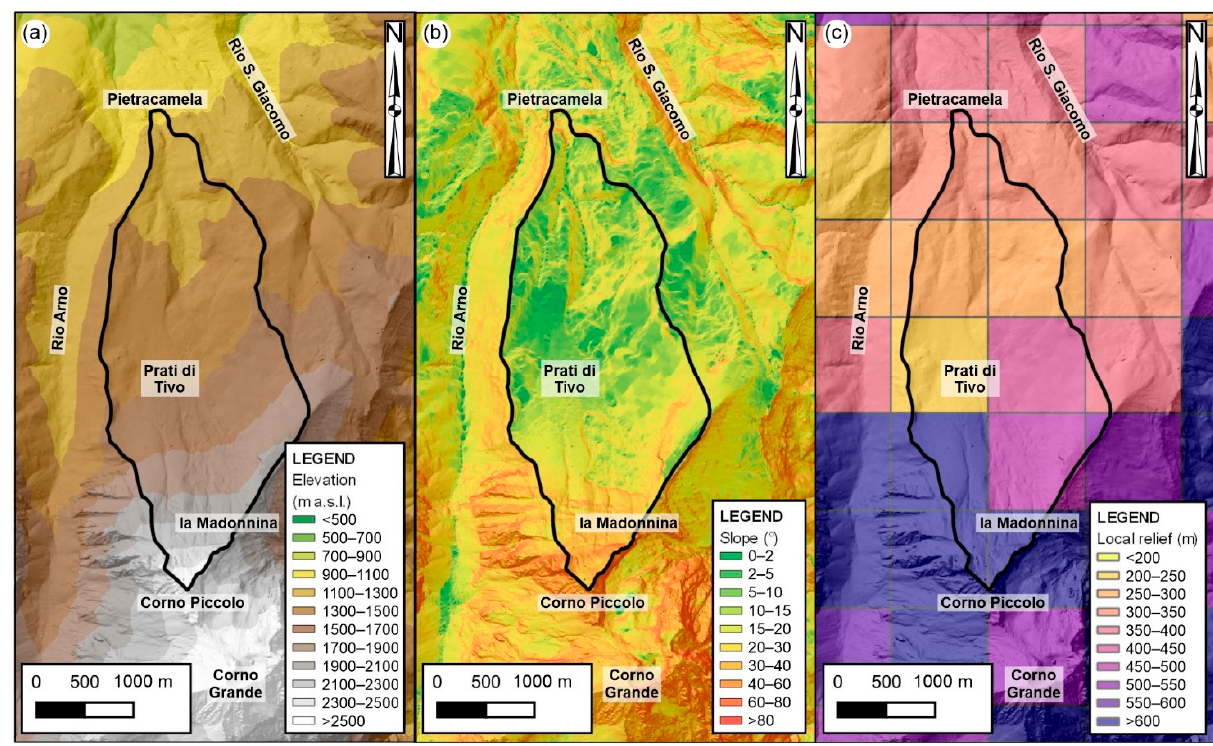
Figure 5. Physiographic features of the study area: ( a ) elevation map, ( b ) slope map, and ( c ) local relief map. The black line represents the study area.